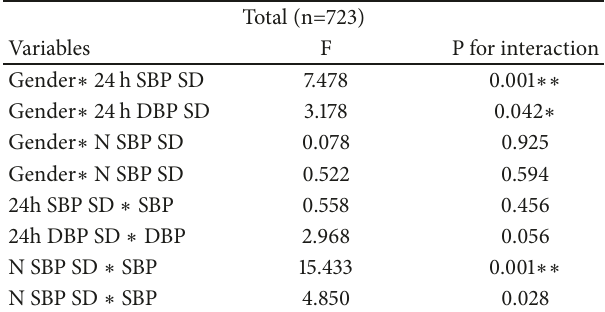
Table 5: A term of interaction between BPV, BP and gender in the multivariate–adjusted linear regression model for total